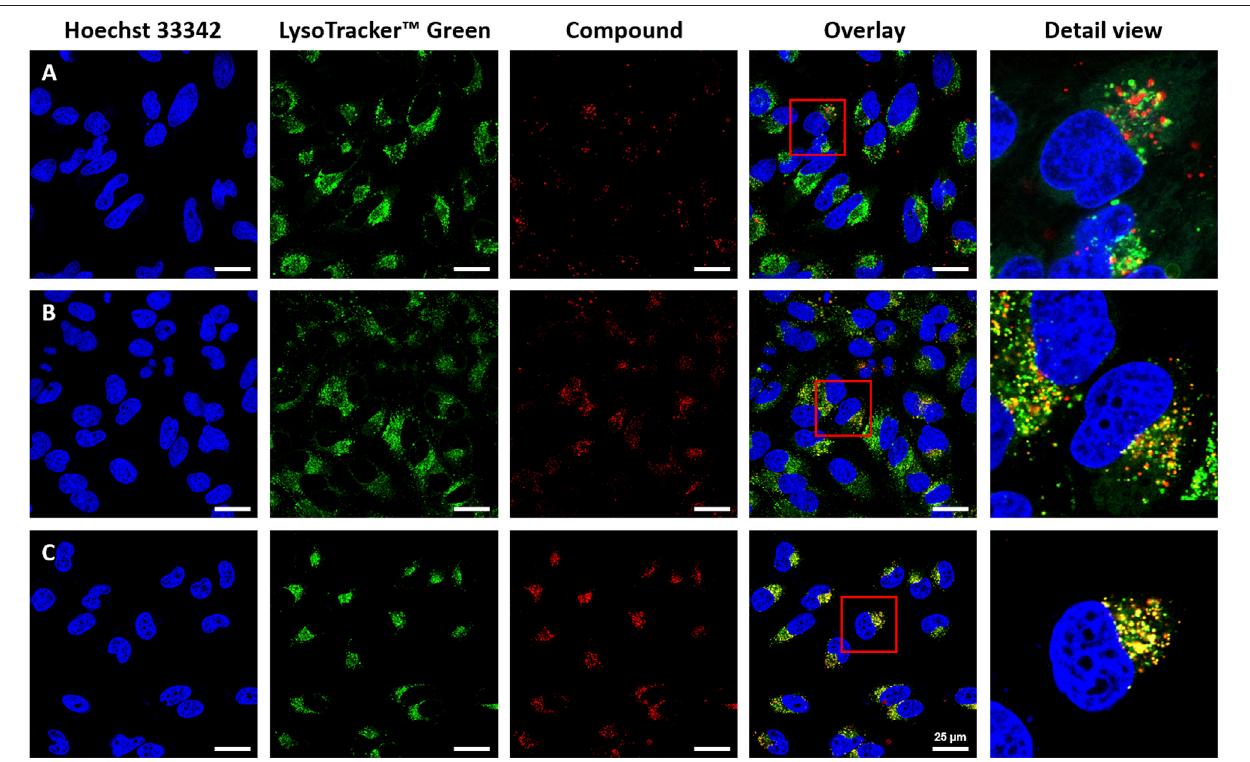
FIGURE 5 | Cellular uptake of heteroleptic bis(dipyrrinato) zinc complexes in HeLa cells ( (A) : 1a , (B) : 1d , (C) : 1e ). For co-staining of nuclei and endosomes, cells were treated with Hoechst 33,342 ( λ exc (cid:1) 405nm, λ em (cid:1) 414 – 462 nm), Lysotracker ™ Green ( λ exc (cid:1) 488 nm, λ em 494 – 545 nm); and Hoechst 33,342, compounds 1a , 1d , 1e ( λ exc (cid:1) 630 nm, λ em (cid:1) 640 – 750 nm). Intracellular accumulation of the complexes was detected with fl uorescence confocal microscopy using a Leica Stellaris 5 with a white light laser. The overlay is the merged image of the single-channel fl uorescence images. Scale bars: 25 μ